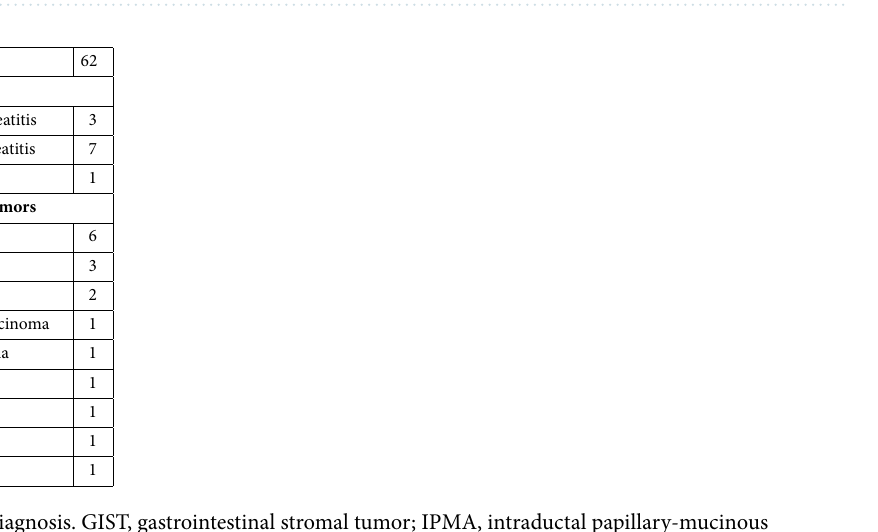
Figure 2. Representative case of pancreatic cancer. ( A ) Hematoxylin and eosin (HE) staining revealed an atypical epithelium with a small amountof tissue, ( B ) Immunohistochemistry for IMP3 revealed moderate (score 2+) staining. ( C ) Immunohistochemistry for P53 was negative.